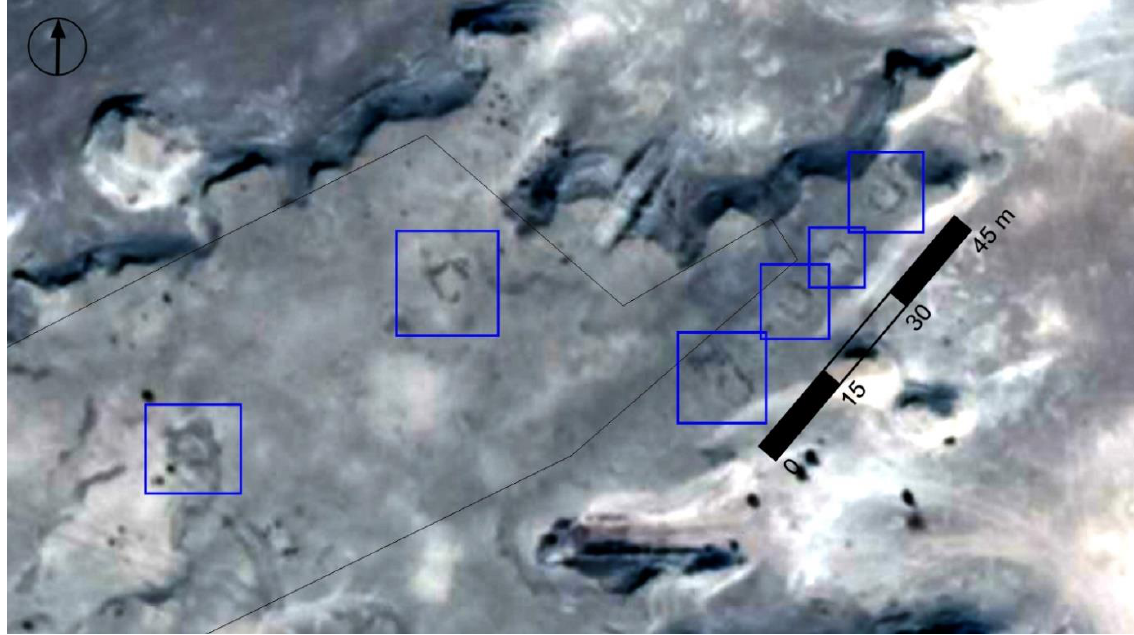
Figure 11: Detail of Fig.10 on a 2016 Image, contrast edited. Looking from the South. (Google / Maxar Technologies